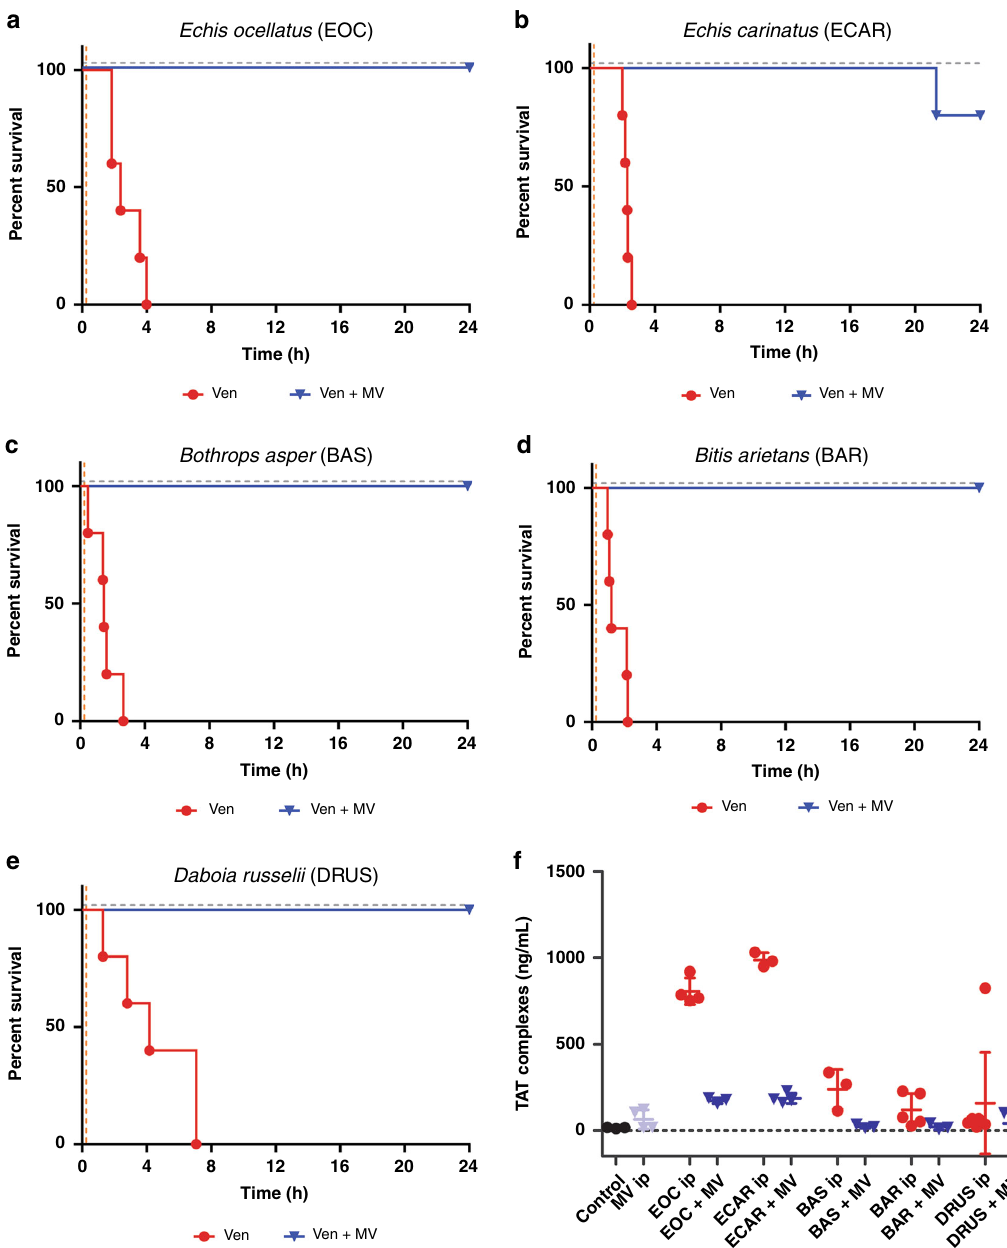
Fig. 6 The inhibitor combination of marimastat and varespladib (MV) provides broad preclinical ef fi cacy against venom lethality in an in vivo ‘ challenge then treat ’ model of envenoming. Kaplan – Meier survival graphs for experimental animals ( n = 5) receiving venom (Ven), followed by delayed drug treatment (15 min later) with a dual combination of marimastat and varespladib. Both venom and treatment were delivered via the intraperitoneal route, and the end of the experiment was at 24 h. Survival of mice receiving: a E. ocellatus (90 µ g, 5× i.v. LD 50 ), b E. carinatus (95 µ g, 5× i.v. LD 50 ), c B. asper (303 µ g, 3× i.p. LD 50 ), d B. arietans (108 µ g, 5× i.v. LD 50 ) and e D. russelii (105 µ g, 13× i.v. LD 50 ) venom, with and without the inhibitor mix (120 µ g of each drug) 15 min later. The drug-only control is presented as a black dashed line at the top of each graph (no toxicity was observed at the given dose). f Quanti fi ed thrombin-antithrombin (TAT) levels in the envenomed animals from ( a ) to ( e ). Where the time of death was the same within experimental groups (e.g., early deaths or complete survival) TAT levels were quanti fi ed for n = 3, and where times of death varied, n = 5. The data displayed represents means of the duplicate technical repeats plus SDs. Source data provided in Supplementary Data (13× i.v. LD 50 , 105 µg) to ensure mortality occurred within 7 h, thus leaving a 17 h window for measuring prolonged survival in the treatment groups.